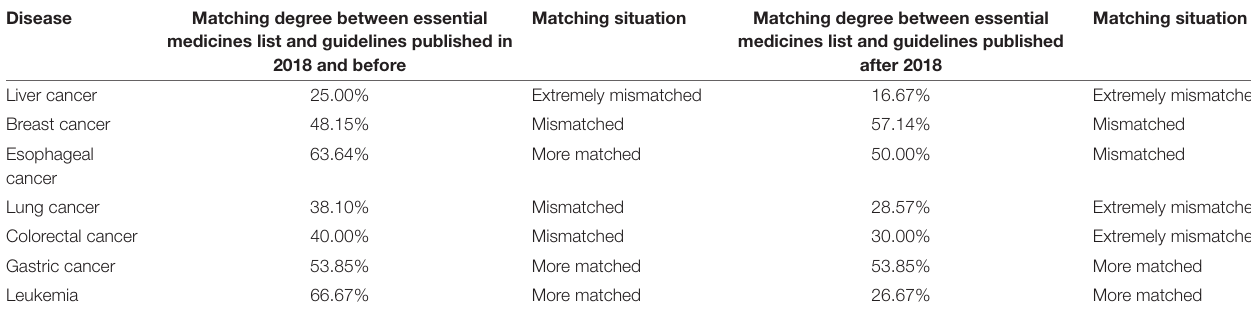
TABLE 8 | Matching degree of essential medicines list and guidelines for different diseases. Disease